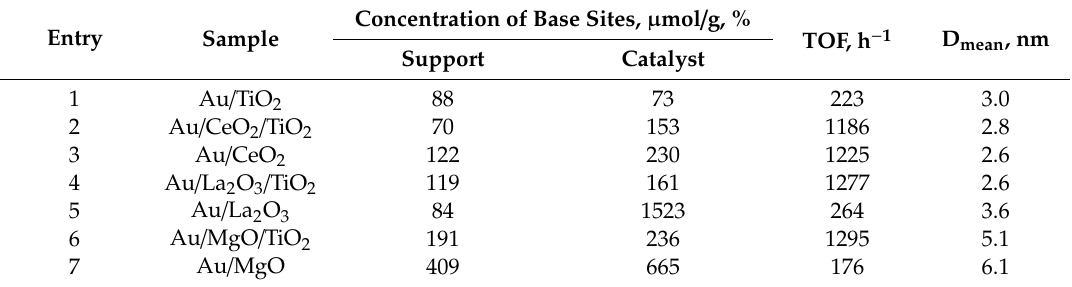
Table 5. Basic properties of the catalysts and corresponding supports, TOF values and mean particle size (D mean ) of the catalysts. Adapted from [37,38], except the data for MgO-based catalysts (entries 6 and 7), which is presented for the first time in this paper.